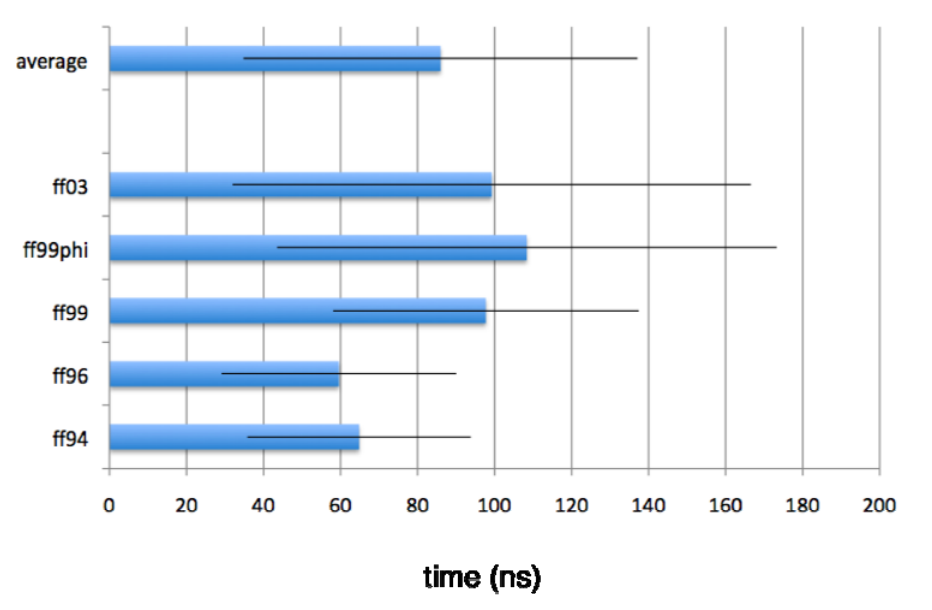
Figure 5. Average simulated relaxation times for D P D P-II, for each forcefield, as characterized by average radius of gyration. Error estimates are computed from the standard deviation across the 10 starting conformations.